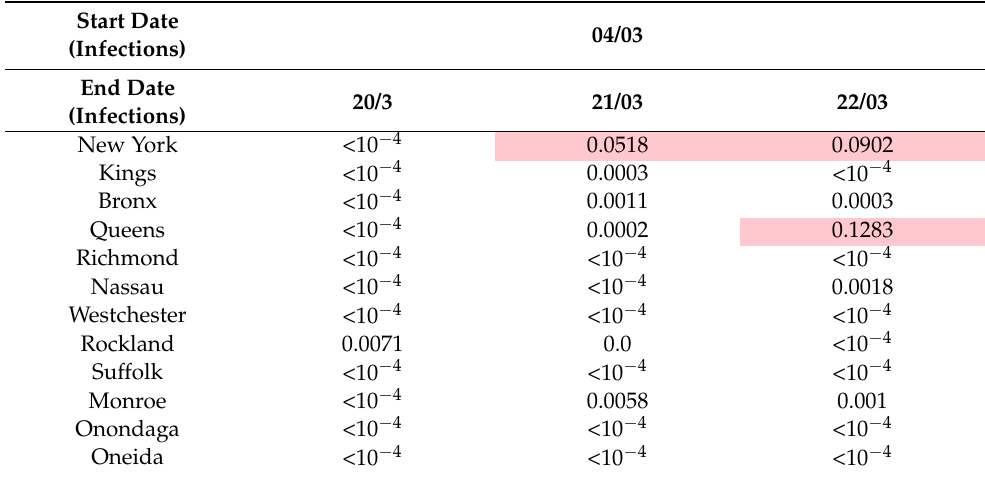
Table 4. Results of the Granger causality